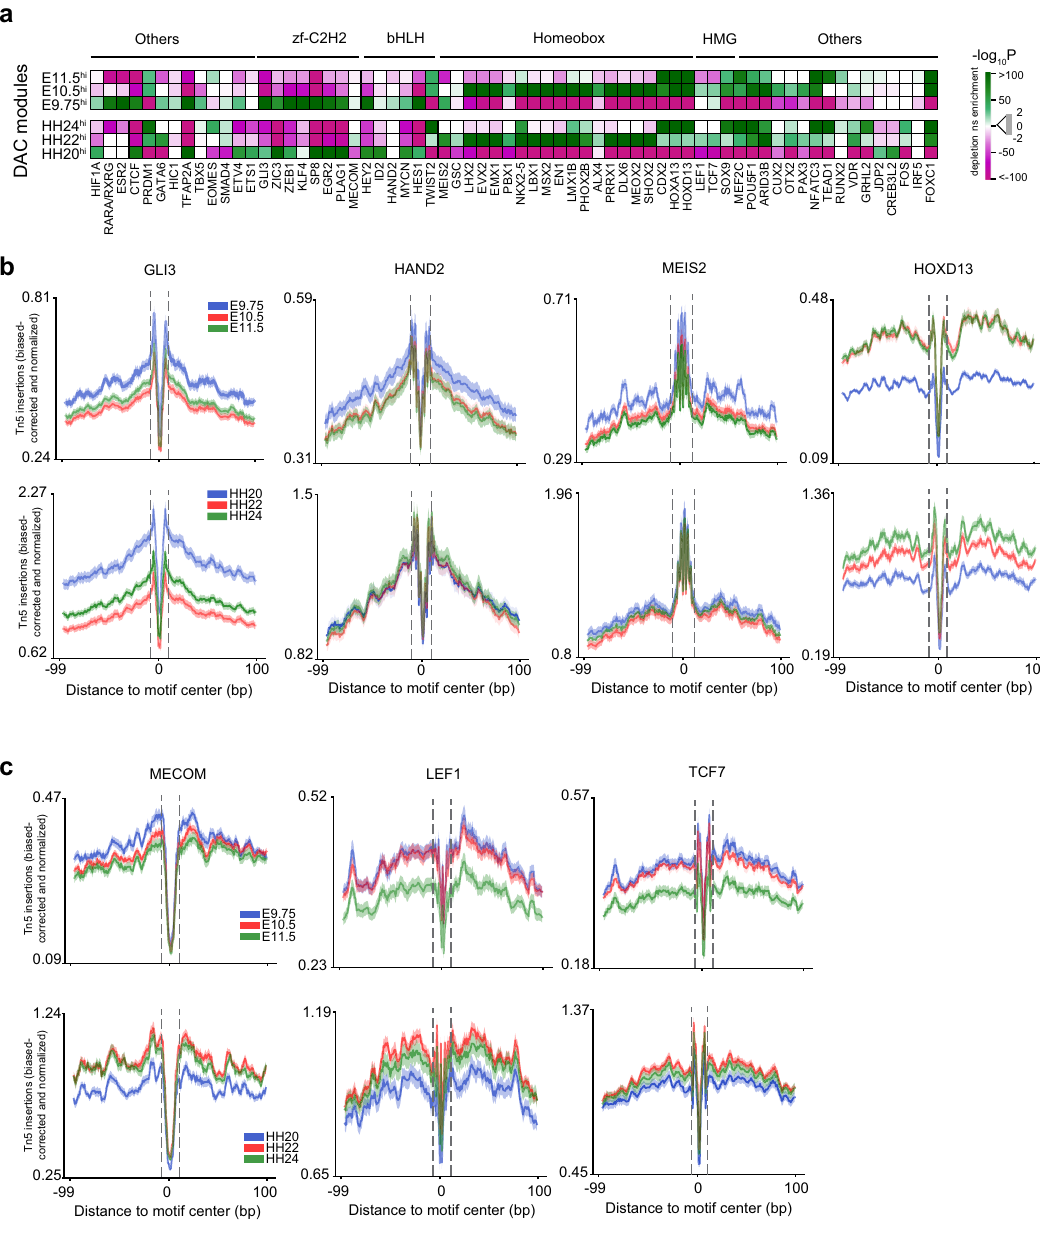
Fig. 5 In silico prediction of TF binding activity within DACs reveal stage-speci fi c TF – DNA interaction dynamics in both species. a Heatmap showing signi fi cantly enriched or depleted TFBS within DAC-hi modules of mouse forelimb (top panel) and chicken wing buds (bottom panel). For each DAC module, signi fi cant enrichment (green) and depletion (magenta) of TF motifs were calculated against unrelated modules with complementary accessibility patterns using analysis of motif enrichment (AME, Supplementary Fig. 7a, b, Methods). b Visualization of the ATAC-seq footprints for key transcription factors that function in AP (GLI3 and HAND2) and PD (MEIS2 and HOXD13) axes patterning during mouse (upper panel) and chicken limb bud development (lower panel). The average ATAC-seq signal around footprints is shown for select TFs at the three limb bud stages (indicated by different colors). c Shown are the dynamic patterns of the MECOM, LEF1, and TCF7 footprints in mouse and chicken limb buds. Dashed lines demarcate the consensus TF binding motif regions and their sequence LOGOS showing information content at each nucleotide are shown in Supplementary Fig. 7d. DAC differentially accessible chromatin regions, TFBS transcription factor binding sites. Source data are provided as a Source Data fi identifying additional interactions with key TFs that function in Fig. 6b). Moreover, GLI3- and HAND2-speci fi c interactions were limb bud patterning (Fig. 6b). In fact, the identi fi cation of also detected (GLI3: ~22%; HAND2: ~17%; magenta lines in HAND2 and GLI3 candidate target genes in both species is an Fig. 6b). Similarly, the candidate HAND2 and GLI3 target genes asset given the lack of corresponding ChIP-seq datasets in identi fi ed in chicken wing buds include both co-regulated (gray chickens. lines, Supplementary Fig. 8) and speci fi c candidate target genes Intriguingly, the majority of candidate target genes for the two (GLI3: ~31%; HAND2: ~49%, magenta lines, Supplementary TFs are shared, which points to their transcriptional co-regulation Fig. 8). Furthermore, 35% of the GLI3 and 50% of the HAND2 by GLI3 and HAND2 in mouse forelimb buds (gray lines, target genes are conserved in both species, while the others are